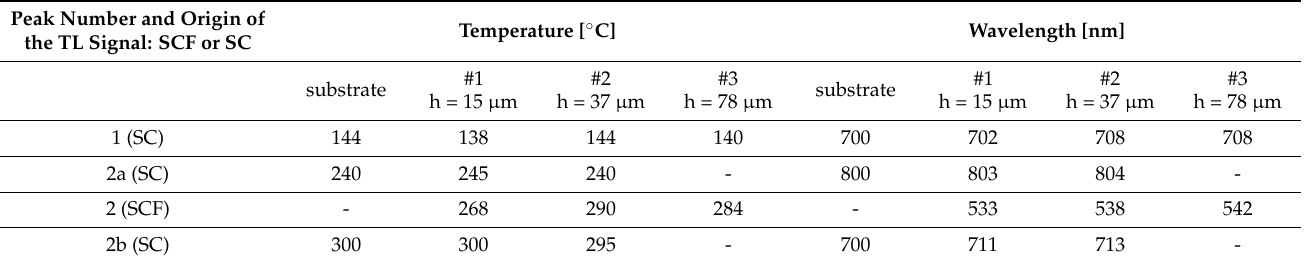
Table 2. Summary of the positions of TL peak maxima on the temperature and wavelength scales. The data are based on the spectrally resolved measurements after 90 Sr/ 90 Y (SC) and 15 kV X-ray (SCF)